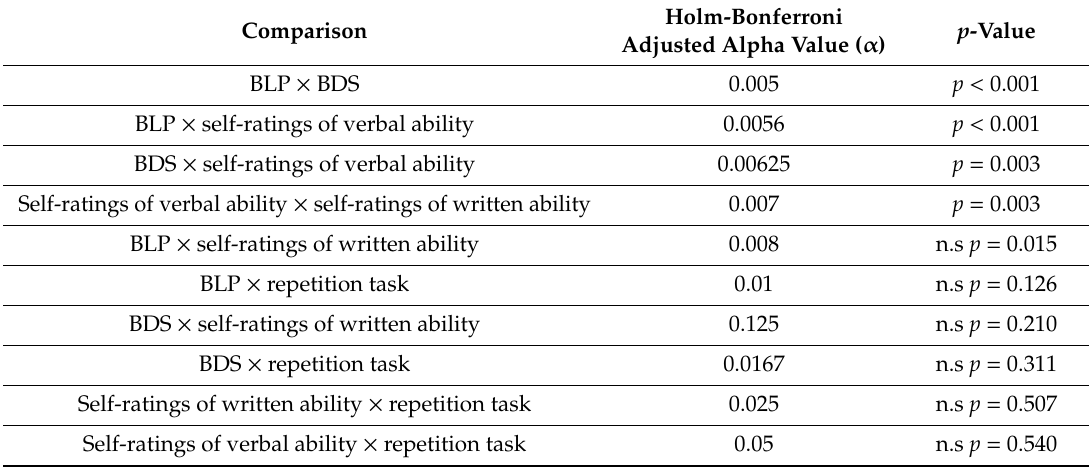
Table 4. Pairwise comparisons of Language Dominance Assessments with Holm-Bonferroni